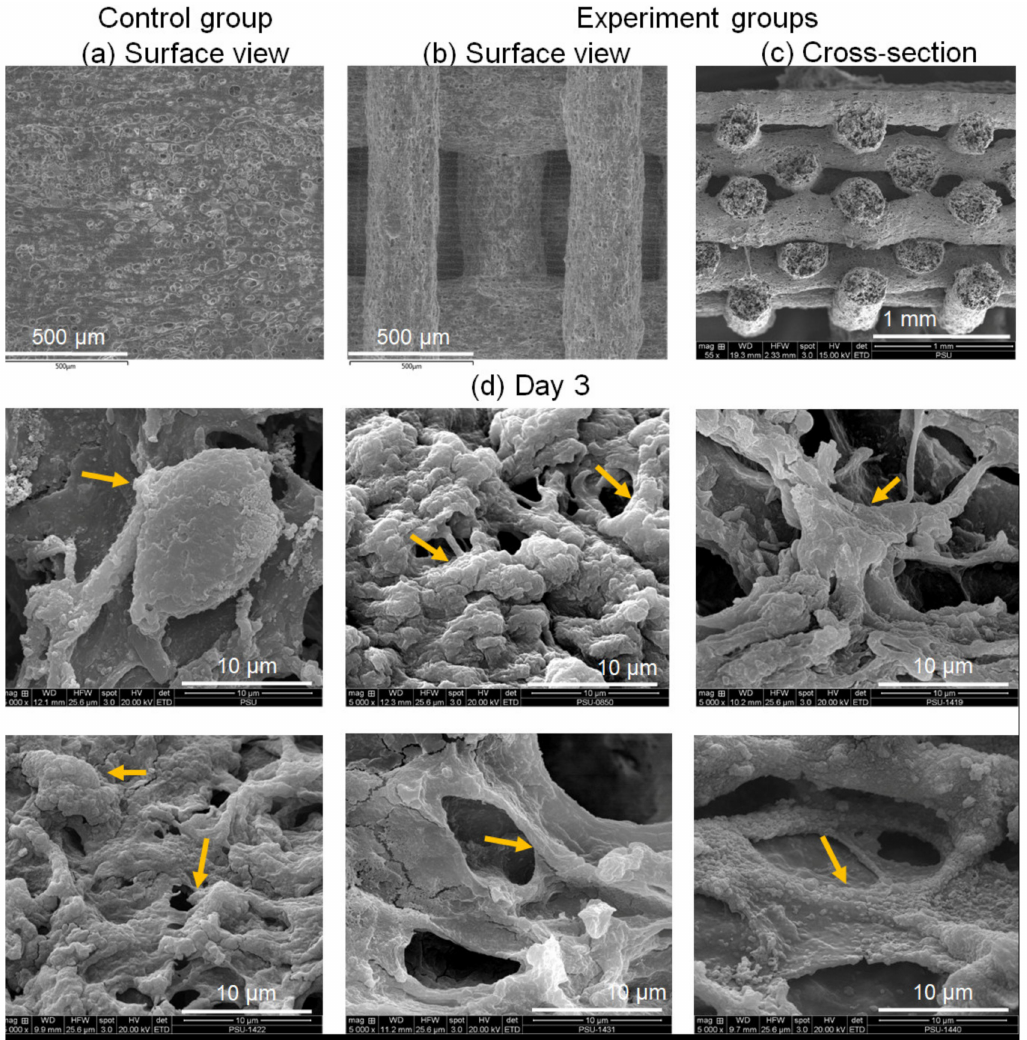
Figure 2. ( a ) SEM image of the surface of the control group. ( b ) Surface view of the experiment groups. ( c ) Cross-sectional view of the experimental groups. ( d ) SEM images show osteoblast cells adhering to the scaffold surface on day 3 of the control, 13%ACP/CSH, and 15%ACP/CSH (left to right on second row) and the 18%ACP/CSH, 20%ACP/CSH, and 23%ACP/CSH (left to right on third row); yellow arrows indicate the osteoblast